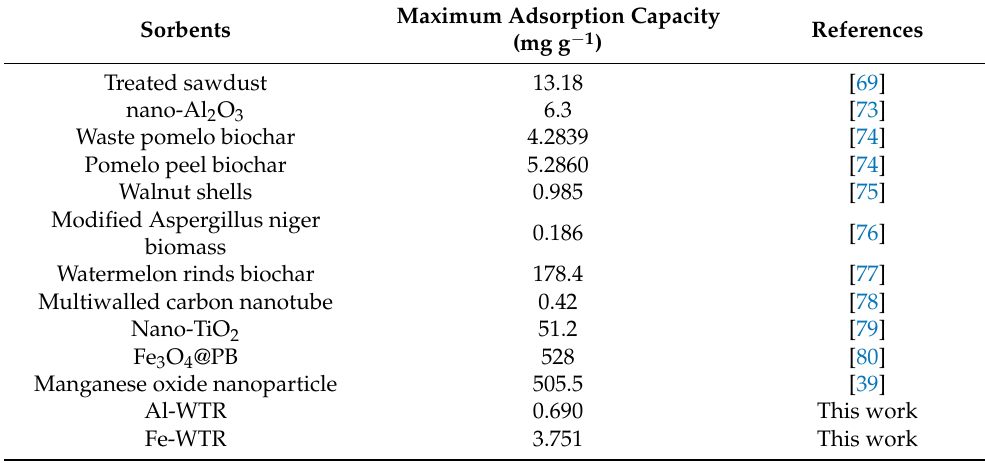
Table 4. Comparison of adsorption capacity of Fe-WTR and Al-WTR with other